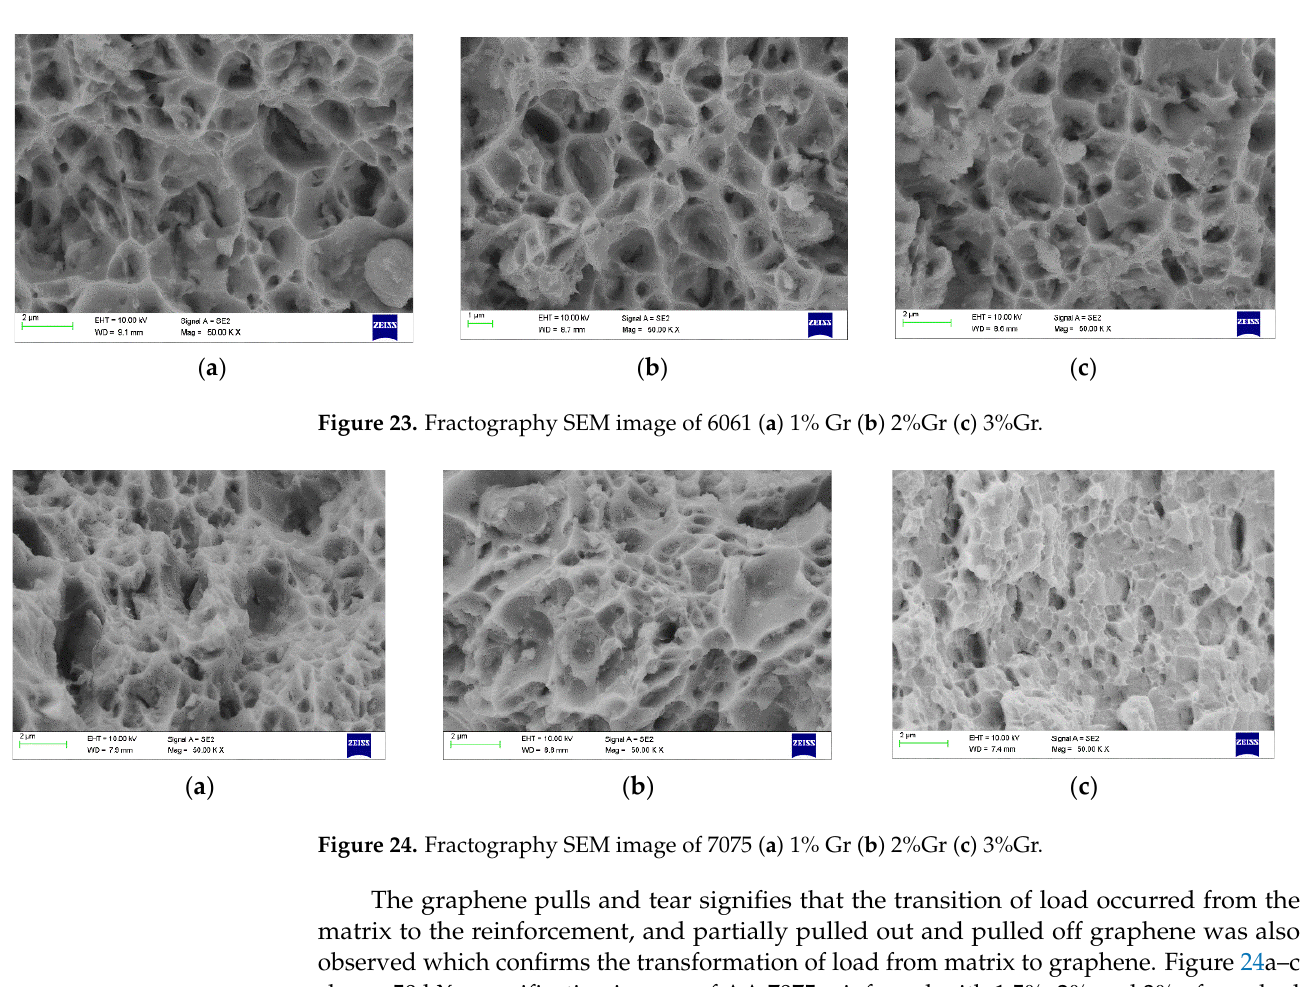
Figure 22. Fractography SEM image of 2024 ( a ) 1% Gr ( b ) 2%Gr ( c ) 3%Gr.